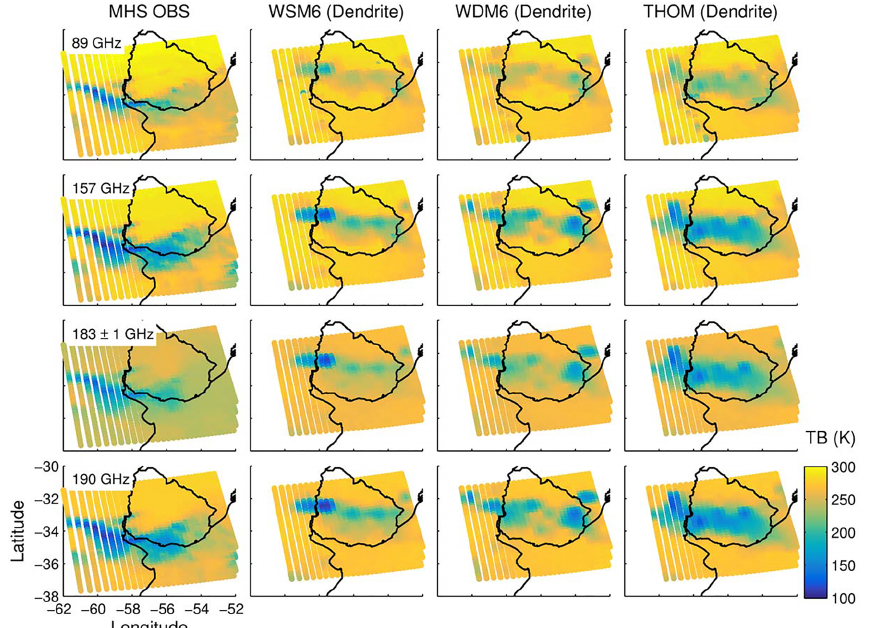
Figure 15. MHS observations at 89, 157, 183 ± 1 and 190GHz, as compared to the corresponding radiative transfer simulations using the dendrite habits for the WSM6, WDM6 and THOM scheme